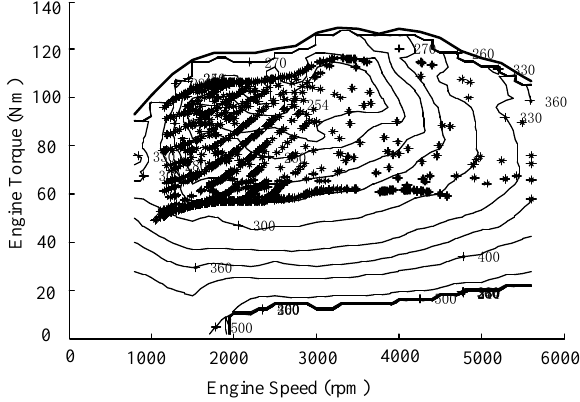
Figure 7. Engine operating points under the comprehensive cycle conditions.